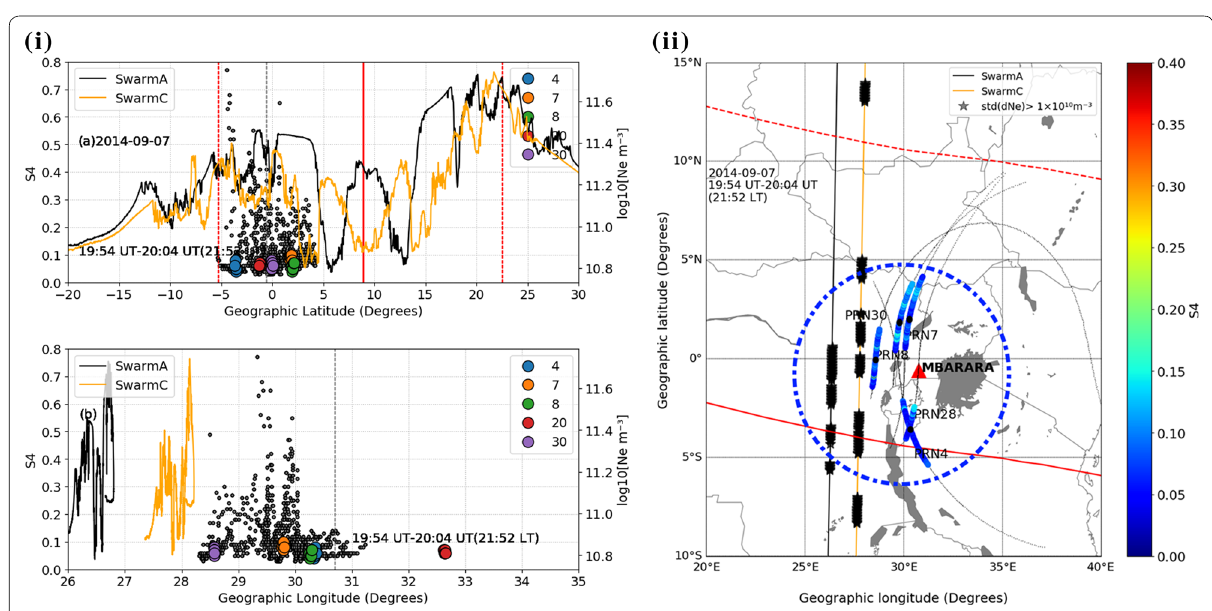
Fig. 4 Similar to Fig. 2 but for Swarm A and C on